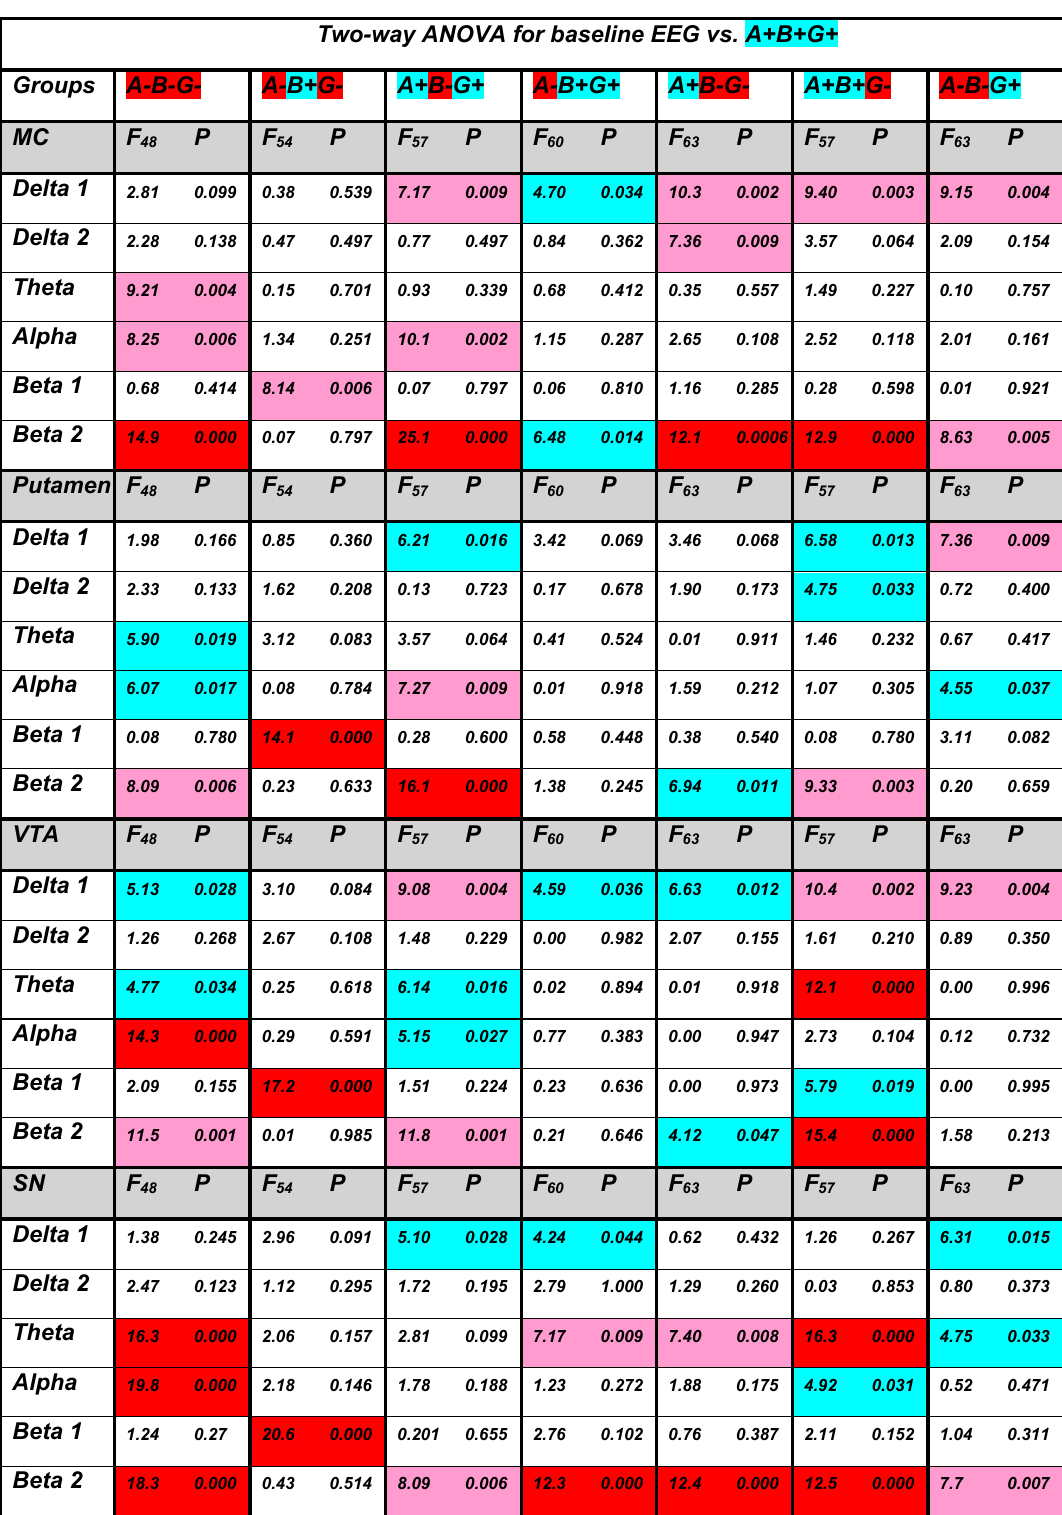
Figure A1. Results of a two-way ANOVA analysis of baseline changes in EEG recordings from four brain areas of synuclein KO mice vs. WT (A+B+G+) mice. Data with p < 0.05 are highlighted blue, p < 0.01 highlighted pink and p < 0.001 highlighted